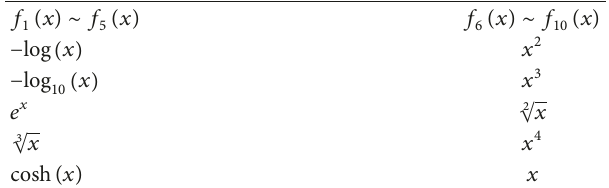
Table 7: Perturbation function to create perturbed